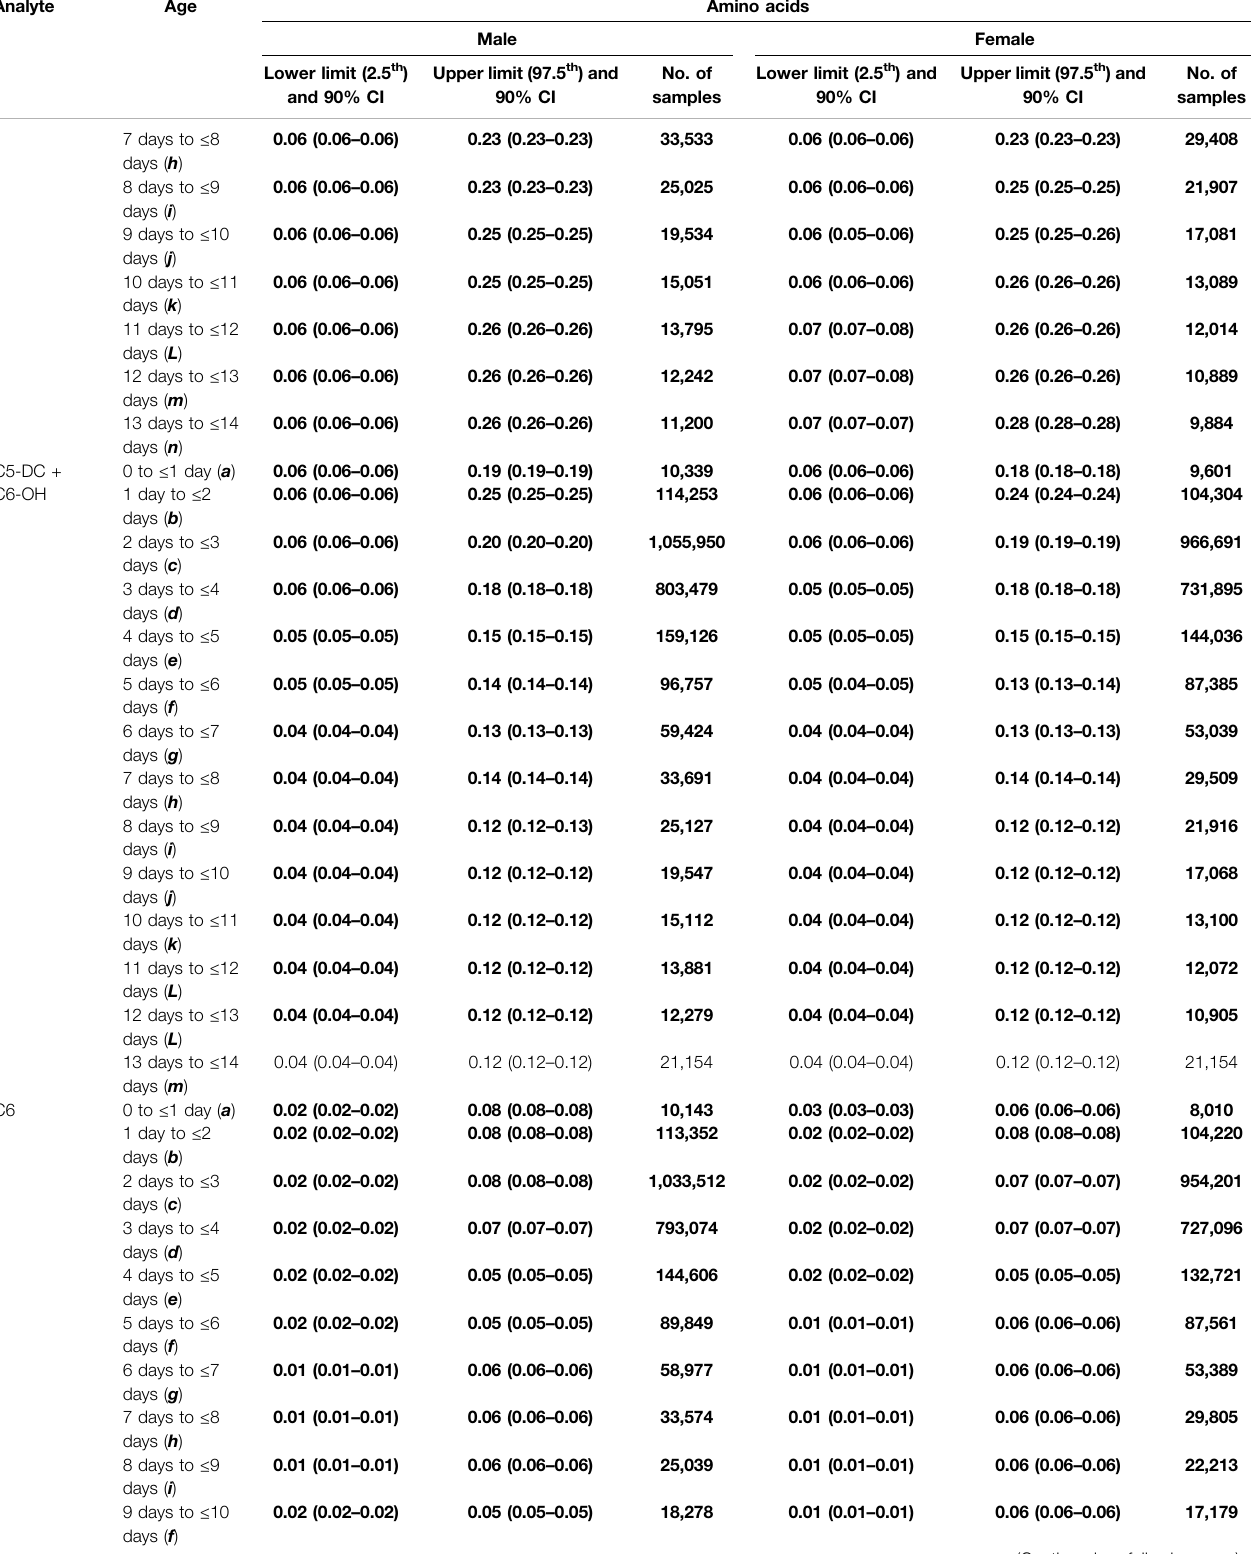
TABLE 2 | ( Continued ) The Reference intervals partitioned by each day and sex for 35 MS/MS NBS biomarkers ( μ